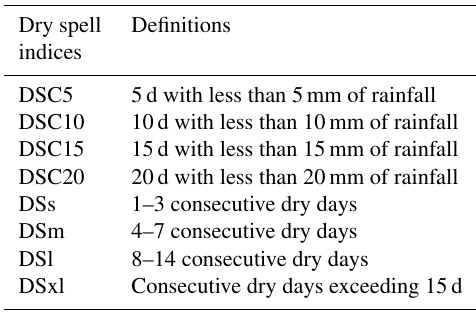
Table 2. Definition of indices for detecting dry